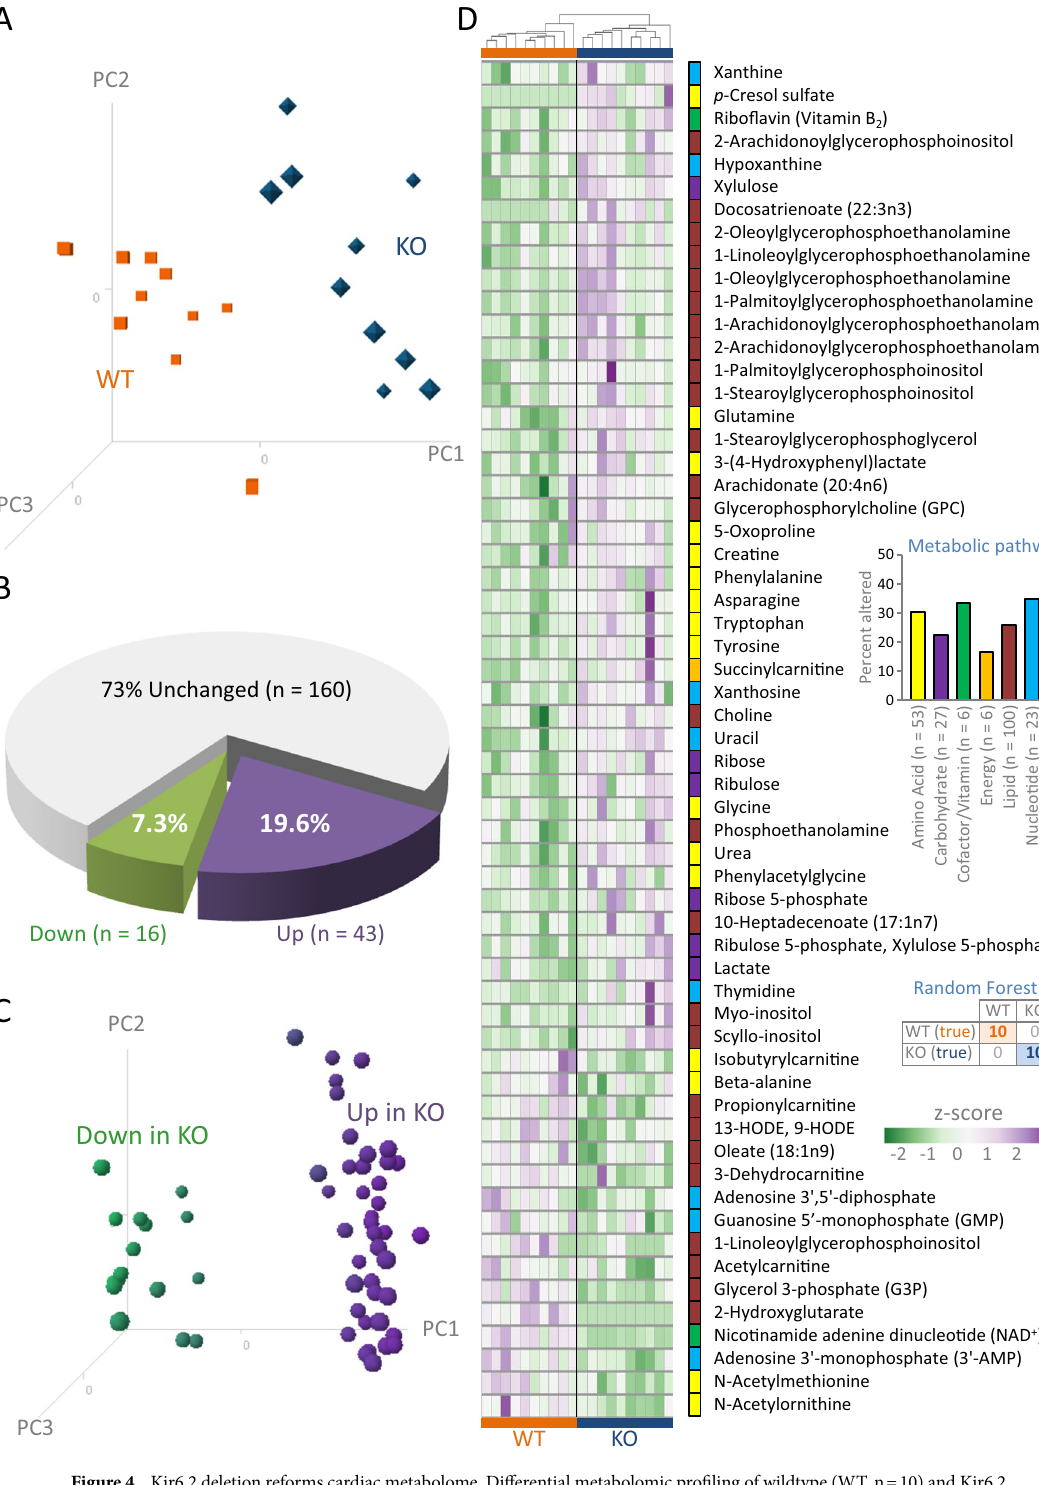
Figure 4. Kir6.2 deletion reforms cardiac metabolome. Differential metabolomic profiling of wildtype (WT, n = 10) and Kir6.2 knockout (KO, n = 10) ventricular tissue extracts was carried out by liquid and gas chromatography mass spectrometry. ( A ) Intra- group clustering and inter-group segregation of WT from KO was evident by singular value decomposition 3-D principal component analysis (PCA), with PC1 representing 44%, PC2 10%, and PC3 8% of the variance yielded from the metabolic data input. ( B ) Of the 219 endogenous metabolites identified, 59 differed significantly between KO and WT ( P < 0.05), with 43 increased (19.6%) and 16 decreased (7.3%). ( C ) PCA loading plots distinguished differentially up/down expressed metabolites. ( D ) Agglomerative clustering by correlation distance and average linkage of z-score transformed differential metabolites, with differential cohort upregulation (purple) and downregulation (green) in response to Kir6.2 deletion, was distributed across multiple metabolic pathways. Identified metabolites spanned 7 pathway macroclusters ( D upper inset , with number of detected metabolites in each pathway indicated) with differential expression distributed across 6 of the 7, impacting 17–35% of detected metabolites per pathway macrocluster. Random Forest modeling of the top thirty differential metabolites accurately classified WT from KO ( D lower inset